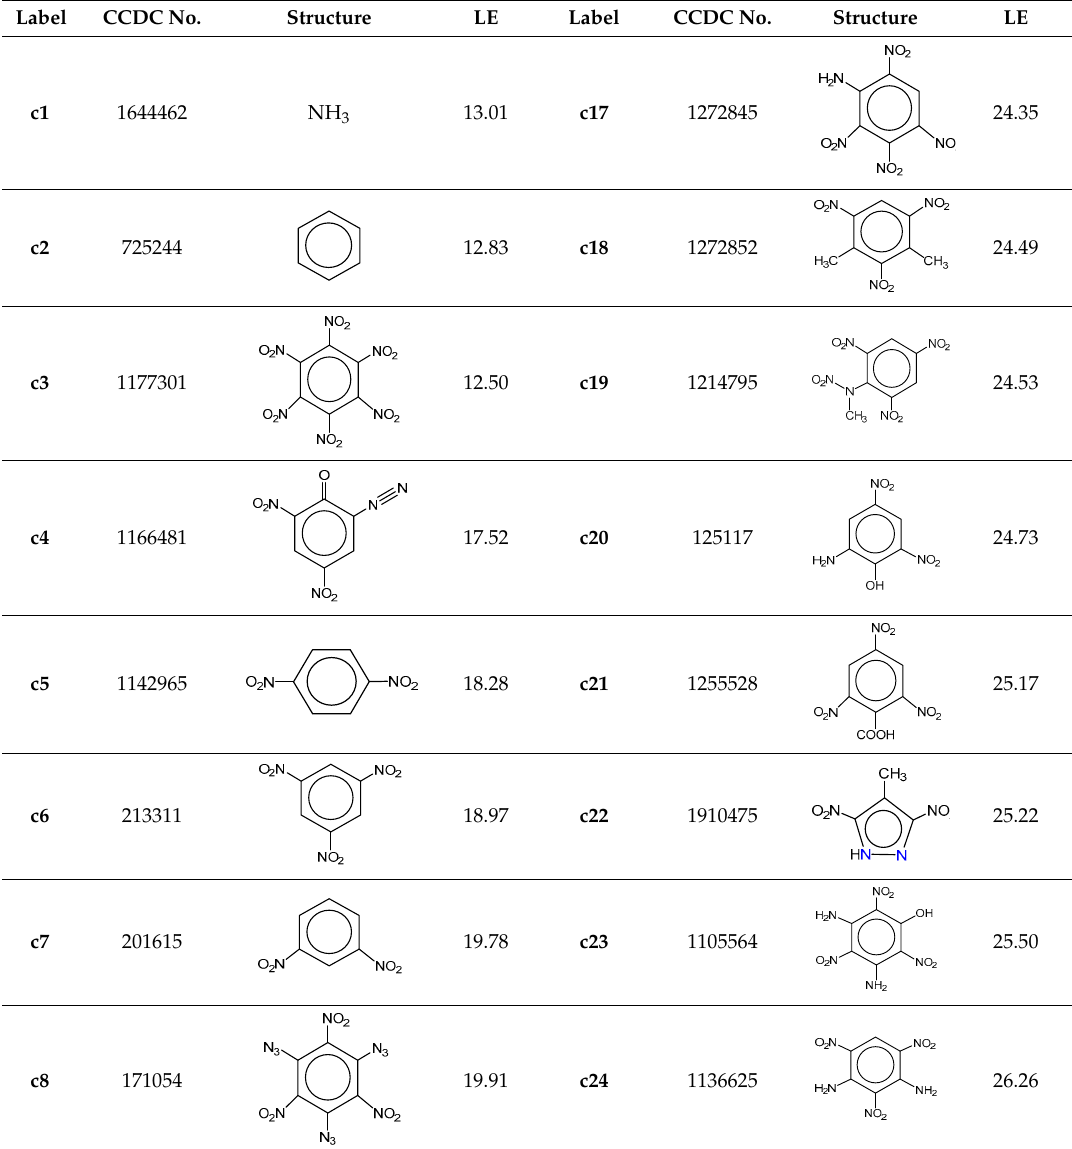
Table 2. Lattice energies (LE, in kcal · mol − 1 ) of 32 crystals composed of ammine and various nitrogen Table 2. Lattice energies (LE, in kcal·mol − 1 ) of 32 crystals composed of ammine and various nitrogen heterocycles. Cambridge Crystallographic Data Centre (CCDC) number of the crystal structures, as Table 2. Lattice energies (LE, in kcal·mol − 1 ) of 32 crystals composed of ammine and various nitrogen Table 2. Lattice energies (LE, in kcal·mol − 1 ) of 32 crystals composed of ammine and various nitrogen Table 2. Lattice energies (LE, in kcal·mol − 1 ) of 32 crystals composed of ammine and various nitrogen Table 2. Lattice energies (LE, in kcal·mol − 1 ) of 32 crystals composed of ammine and various nitrogen Table 2. Lattice energies (LE, in kcal·mol − 1 ) of 32 crystals composed of ammine and various nitrogen Table 2. Lattice energies (LE, in kcal·mol − 1 ) of 32 crystals composed of ammine and various nitrogen heterocycles. Cambridge Crystallographic Data Centre (CCDC) number of the crystal structures, as heterocycles. Cambridge Crystallographic Data Centre (CCDC) number of the crystal structures, as well as the chemical structures of the constituent molecules are provided. heterocycles. Cambridge Crystallographic Data Centre (CCDC) number of the crystal structures, as Table 2. Lattice energies (LE, in kcal·mol − 1 ) of 32 crystals composed of ammine and various heterocycles. Cambridge Crystallographic Data Centre (CCDC) number of the crystal structures, as well as the chemical structures of the constituent molecules are provided. well as the chemical structures of the constituent molecules are provided. well as the chemical structures of the constituent molecules are provided. well as the chemical structures of the constituent molecules are provided.